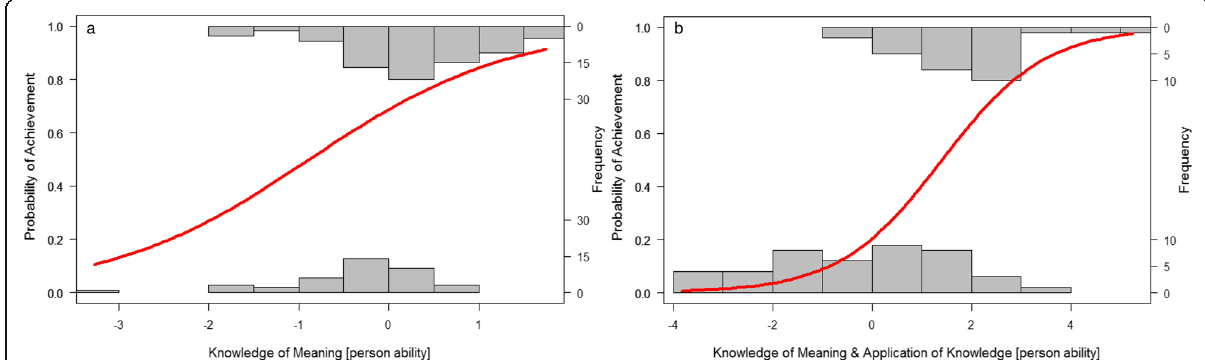
Fig. 2 Prediction curve and observed scores for academic achievement in the first year. Logistic curve and distribution of the academic achievers (upper part) and non-achievers (lower part). a Biology sample, logistic curve of the prediction of model E. b Physics sample, logistic curve of the prediction of model